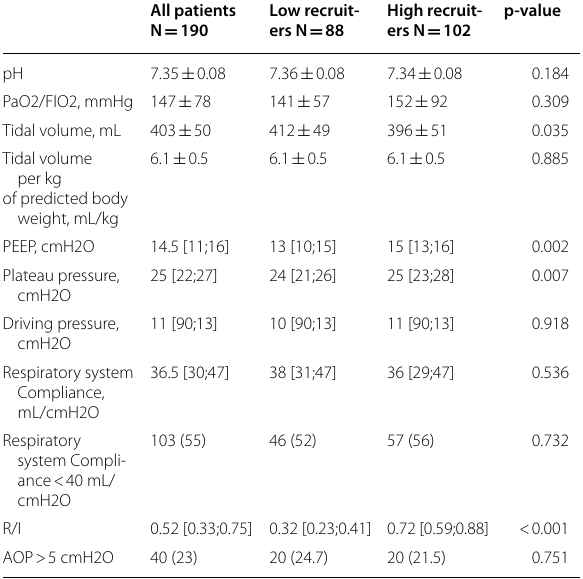
Table: characteristics of the patients according to recruitability. Data are shown as mean SD, meadian [IQR] or n ±